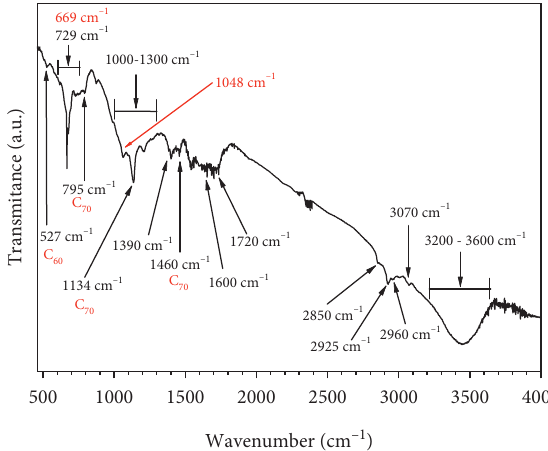
Figure 3: FTIR spectrum of soot deposits obtained in the IRMPD of 2.5hPa of